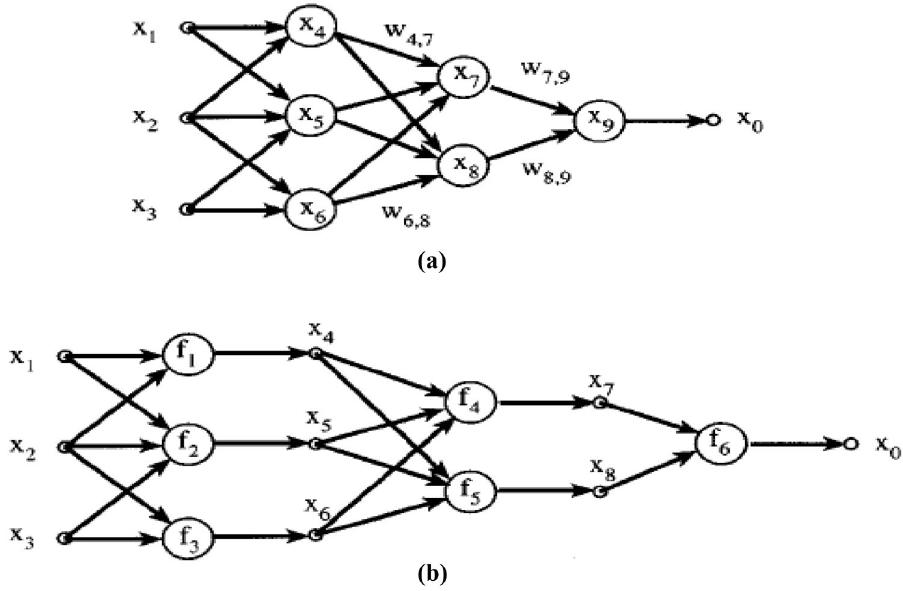
Fig. 4 a ANN structure against b FN structure